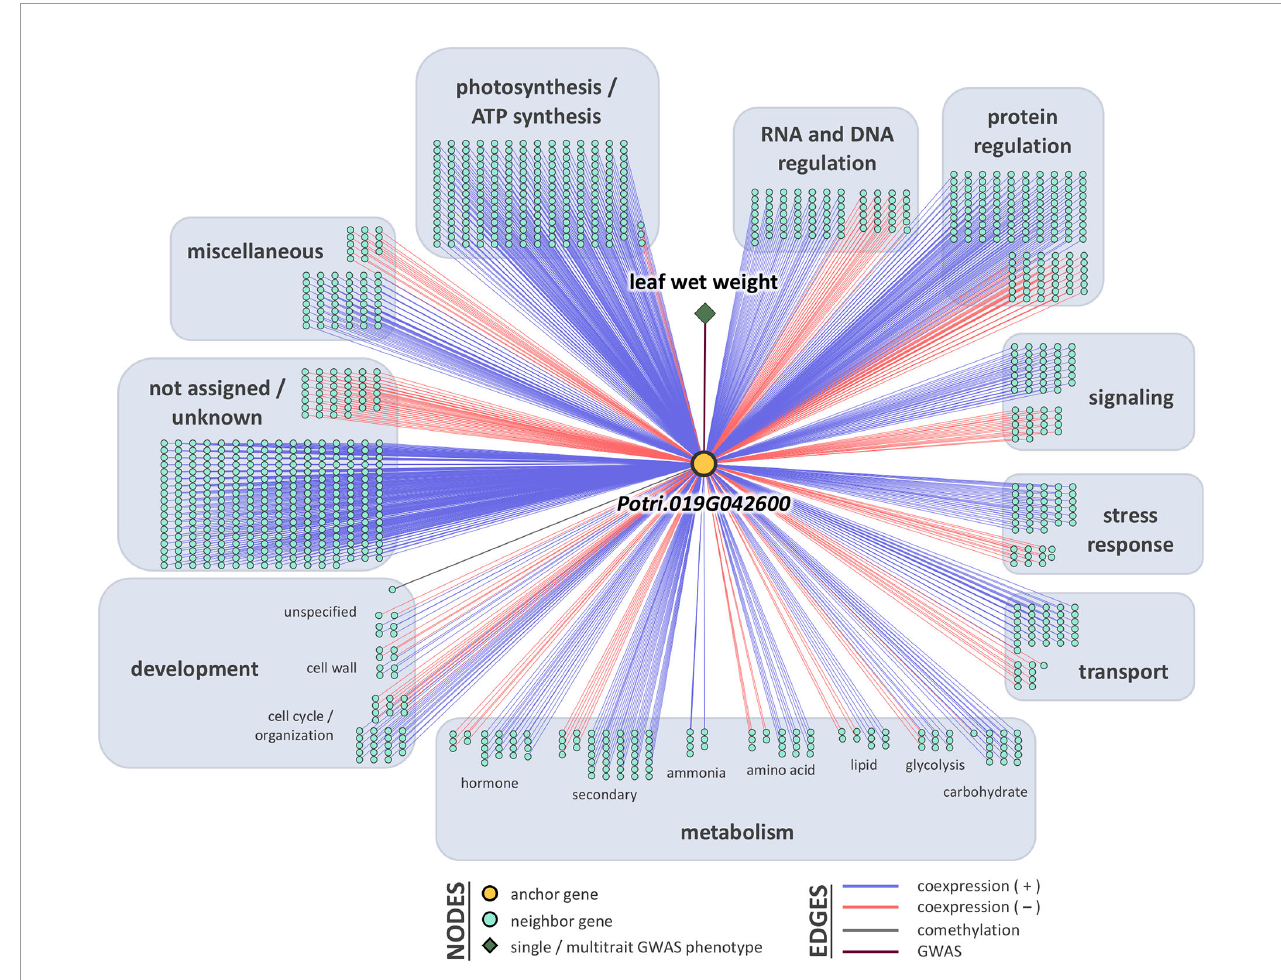
FIGURE 6 | One-hop multi-omic network for the gene Potri.019G042600, which was associated with leaf wet